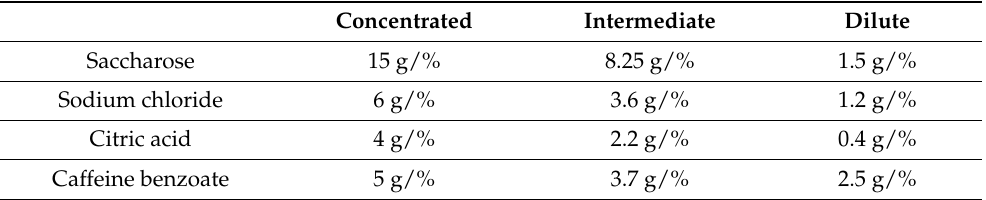
Table 1. Solutions used for the assessment of taste perception and